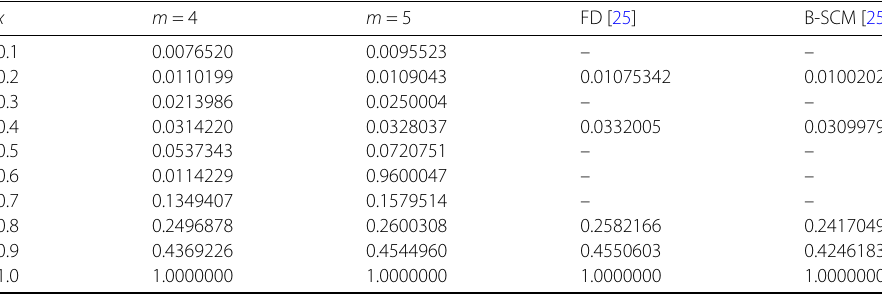
Table 4 Approximated solutions utilizing approach II for λ = 5